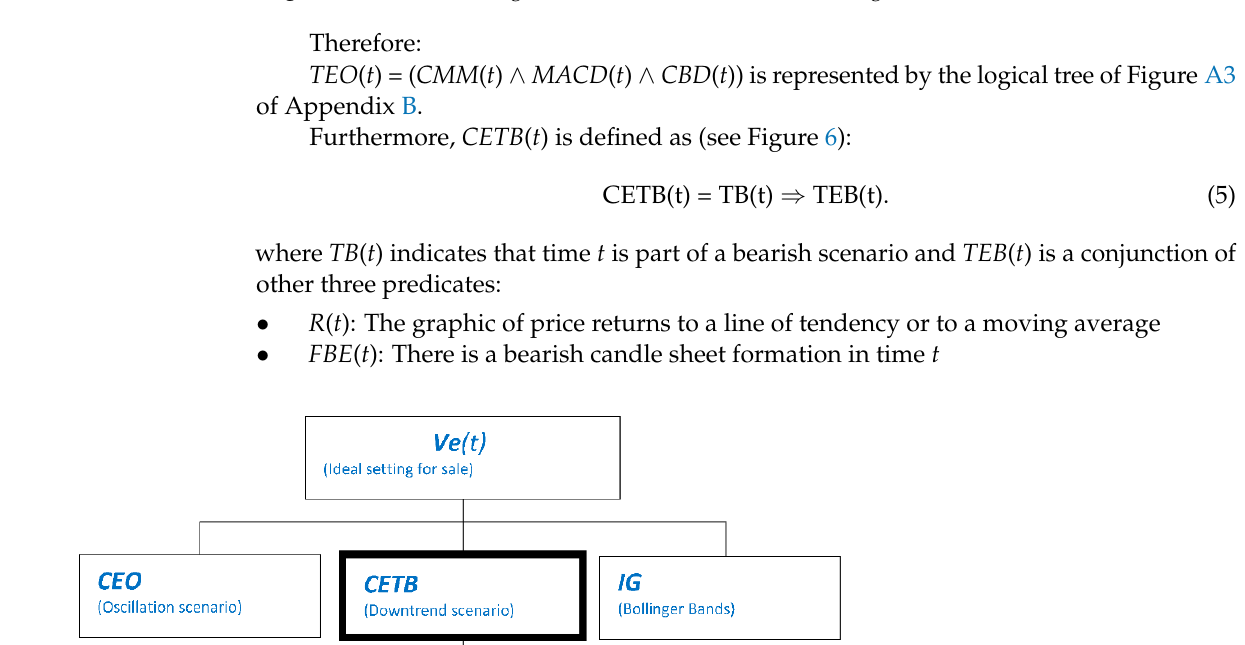
Figure 5. Evaluation of “good oscillation conditions for selling”.